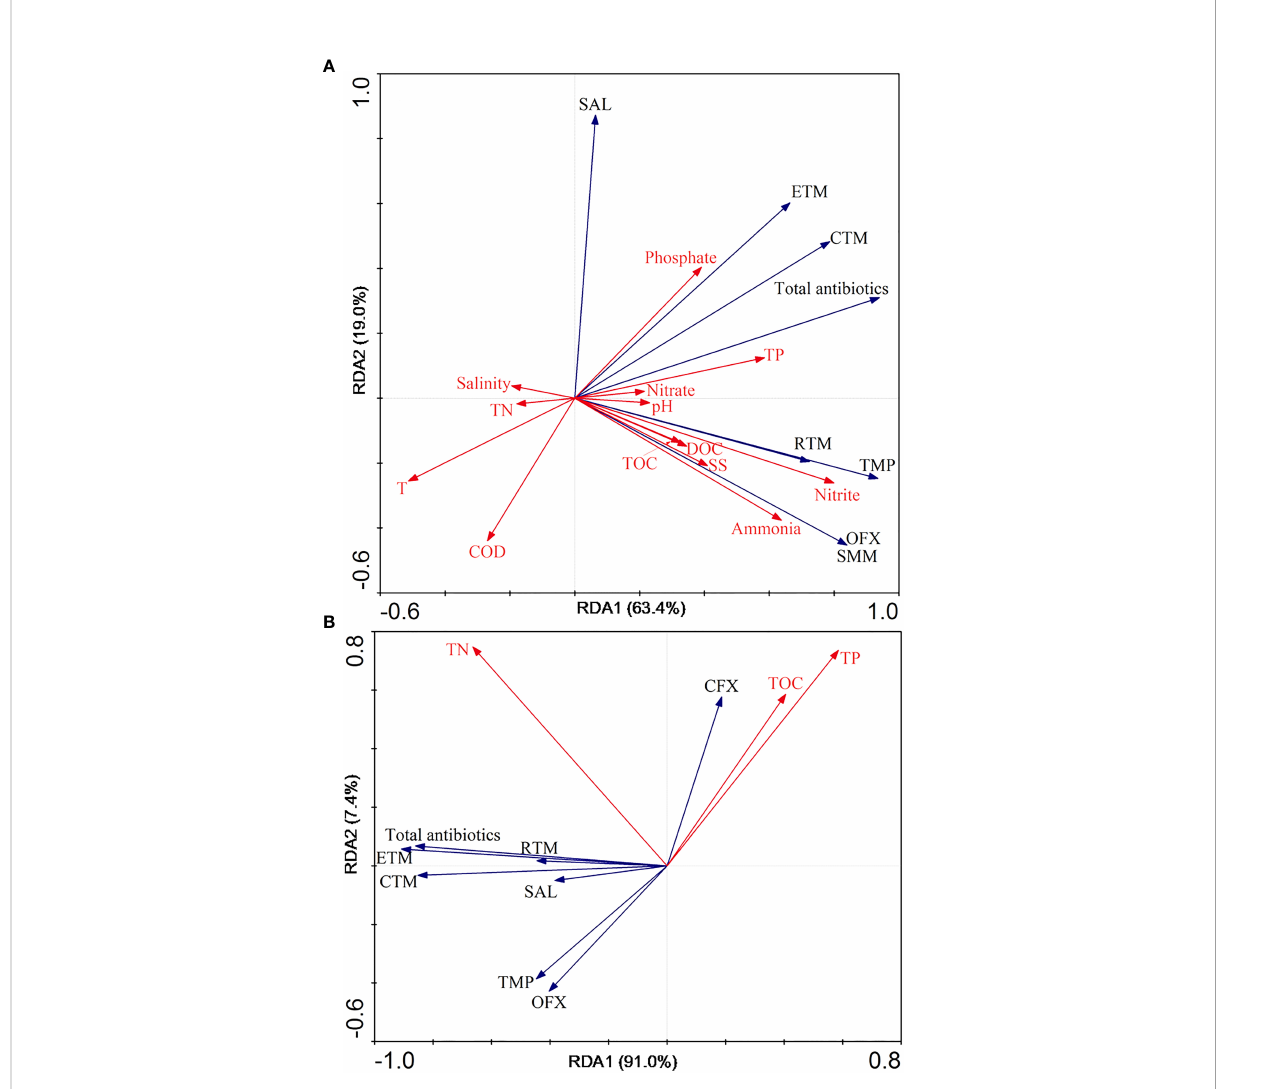
FIGURE 2 Correlations between environmental factors and antibiotics in water and sediment in Dapeng Cove, Shenzhen, South China with redundancy analysis. (A) water samples. (B) sediment